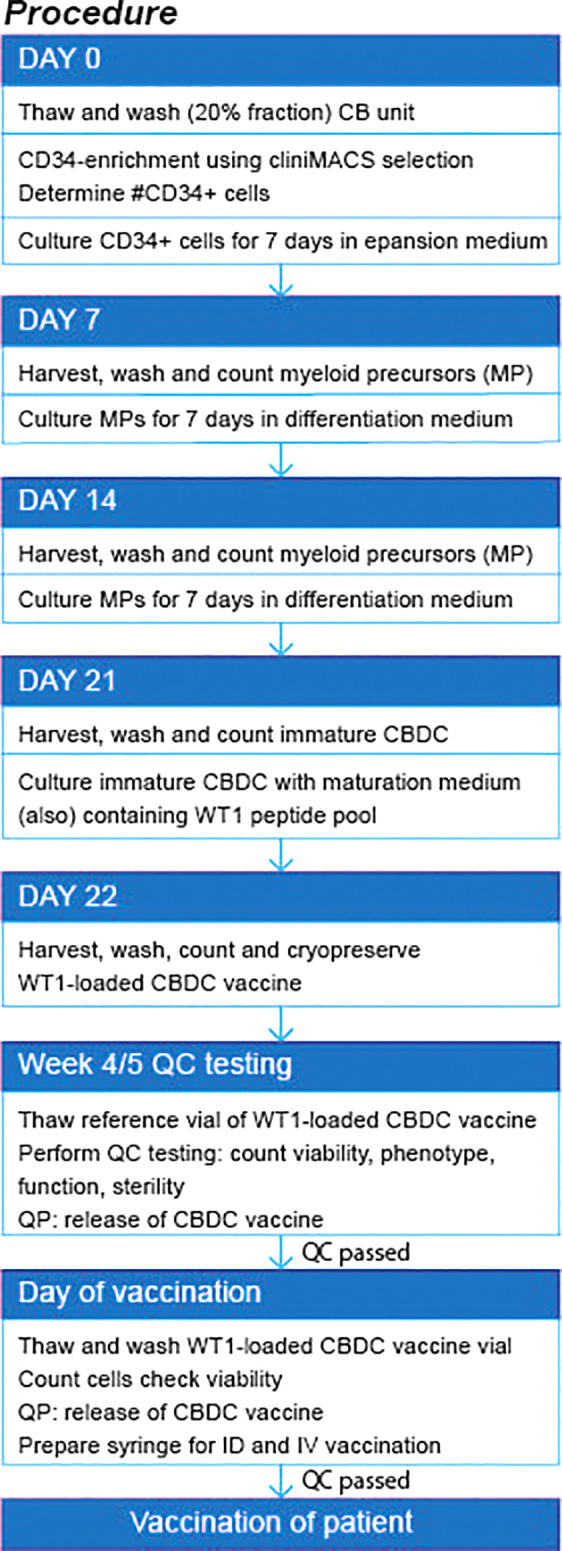
Flow diagram of production procedure. QP, quality personal; QC, quality control. ID, intradermal; IV, intravenous.